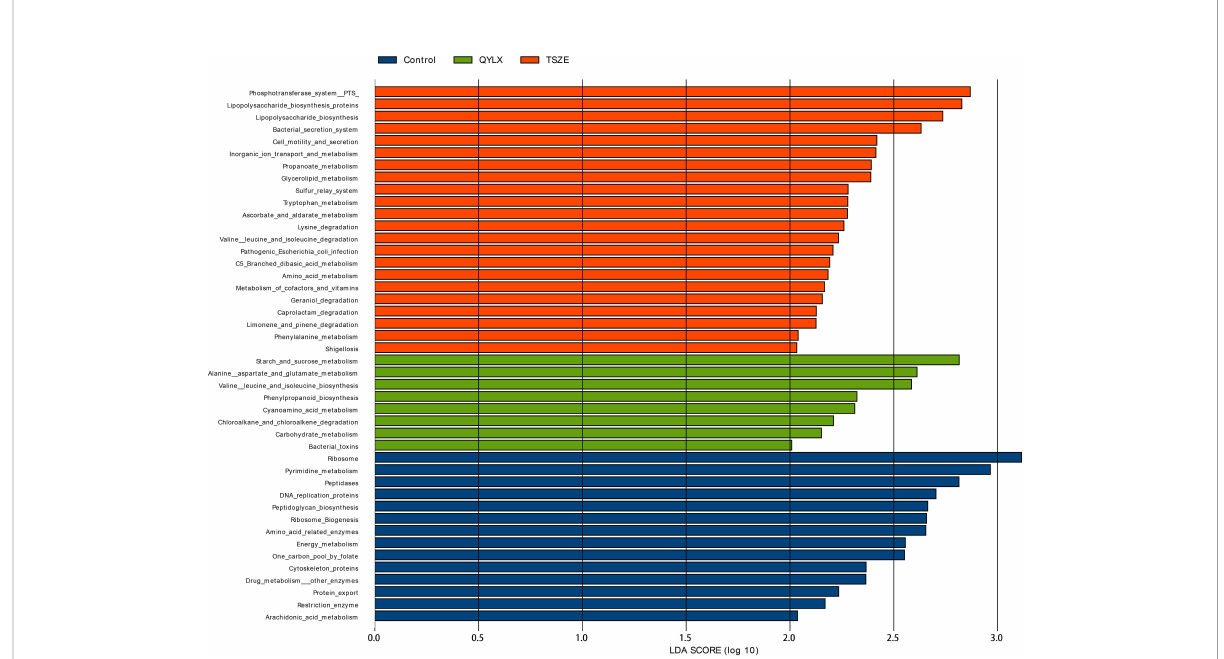
FIGURE 6 Speci fi c microbiota functions differentially abundant among QYLX, TSZE patients and healthy control. The full list of signi fi cant KEGG pathways enriched in each of the 3 groups is identi fi ed with LefSe (linear discriminant analysis effect size), at p value < 0.05 and log10-transformed LDA score > 2. Green: microbial taxa enriched in QYLX group; orange: microbial taxa enriched in TSZE group; blue: microbial taxa enriched in healthy control, thus depleted in both TCM syndromes of MS. QYLX, qi-yin de fi ciency syndrome; TSZE, phlegm-dampness